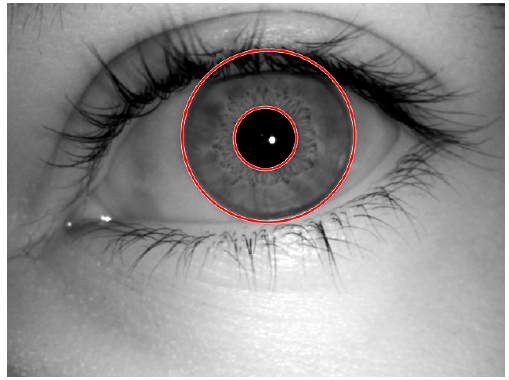
Figure 5. Output of circle detection.